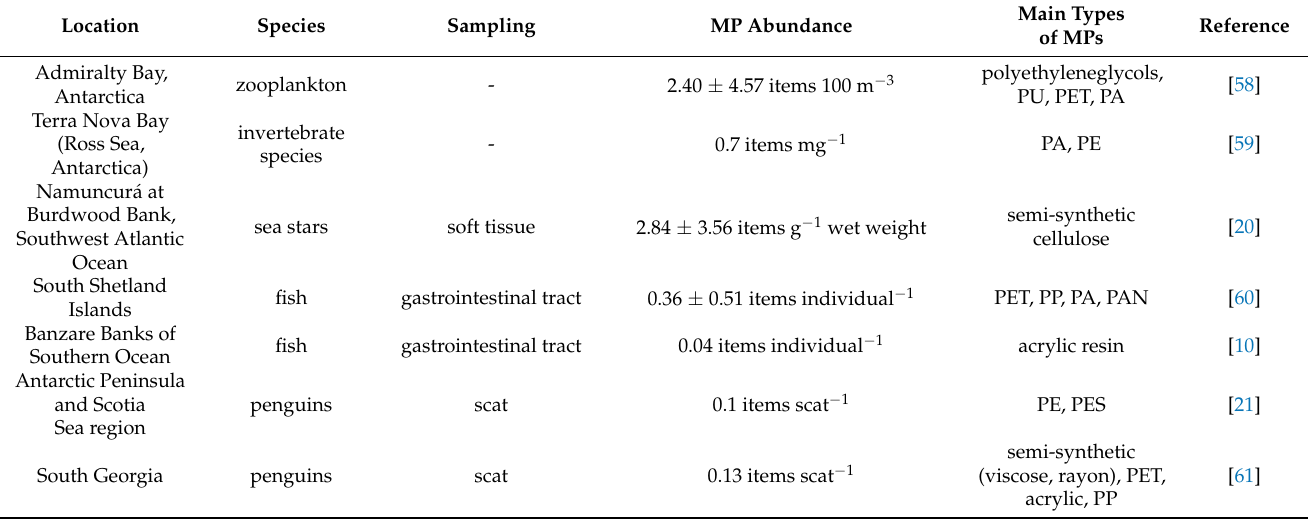
Table 4. Studies on MP abundances in different